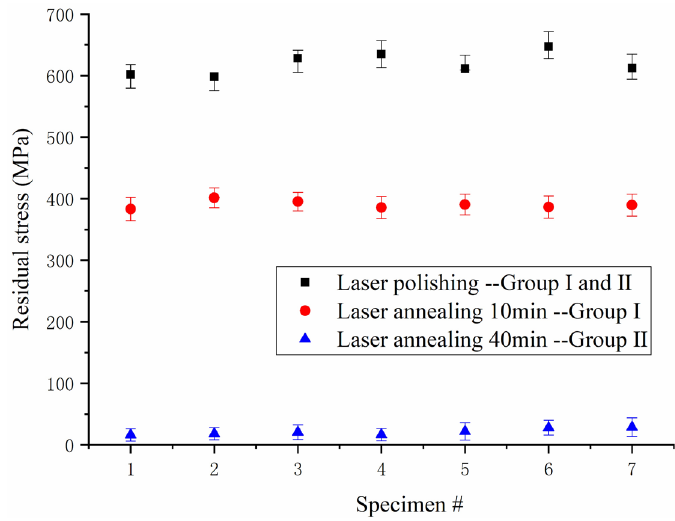
Figure 5. Measurement of tensile residual stress for Group I and Group II. Figure 6. Measurement of tensile residual stress for Group I and Group